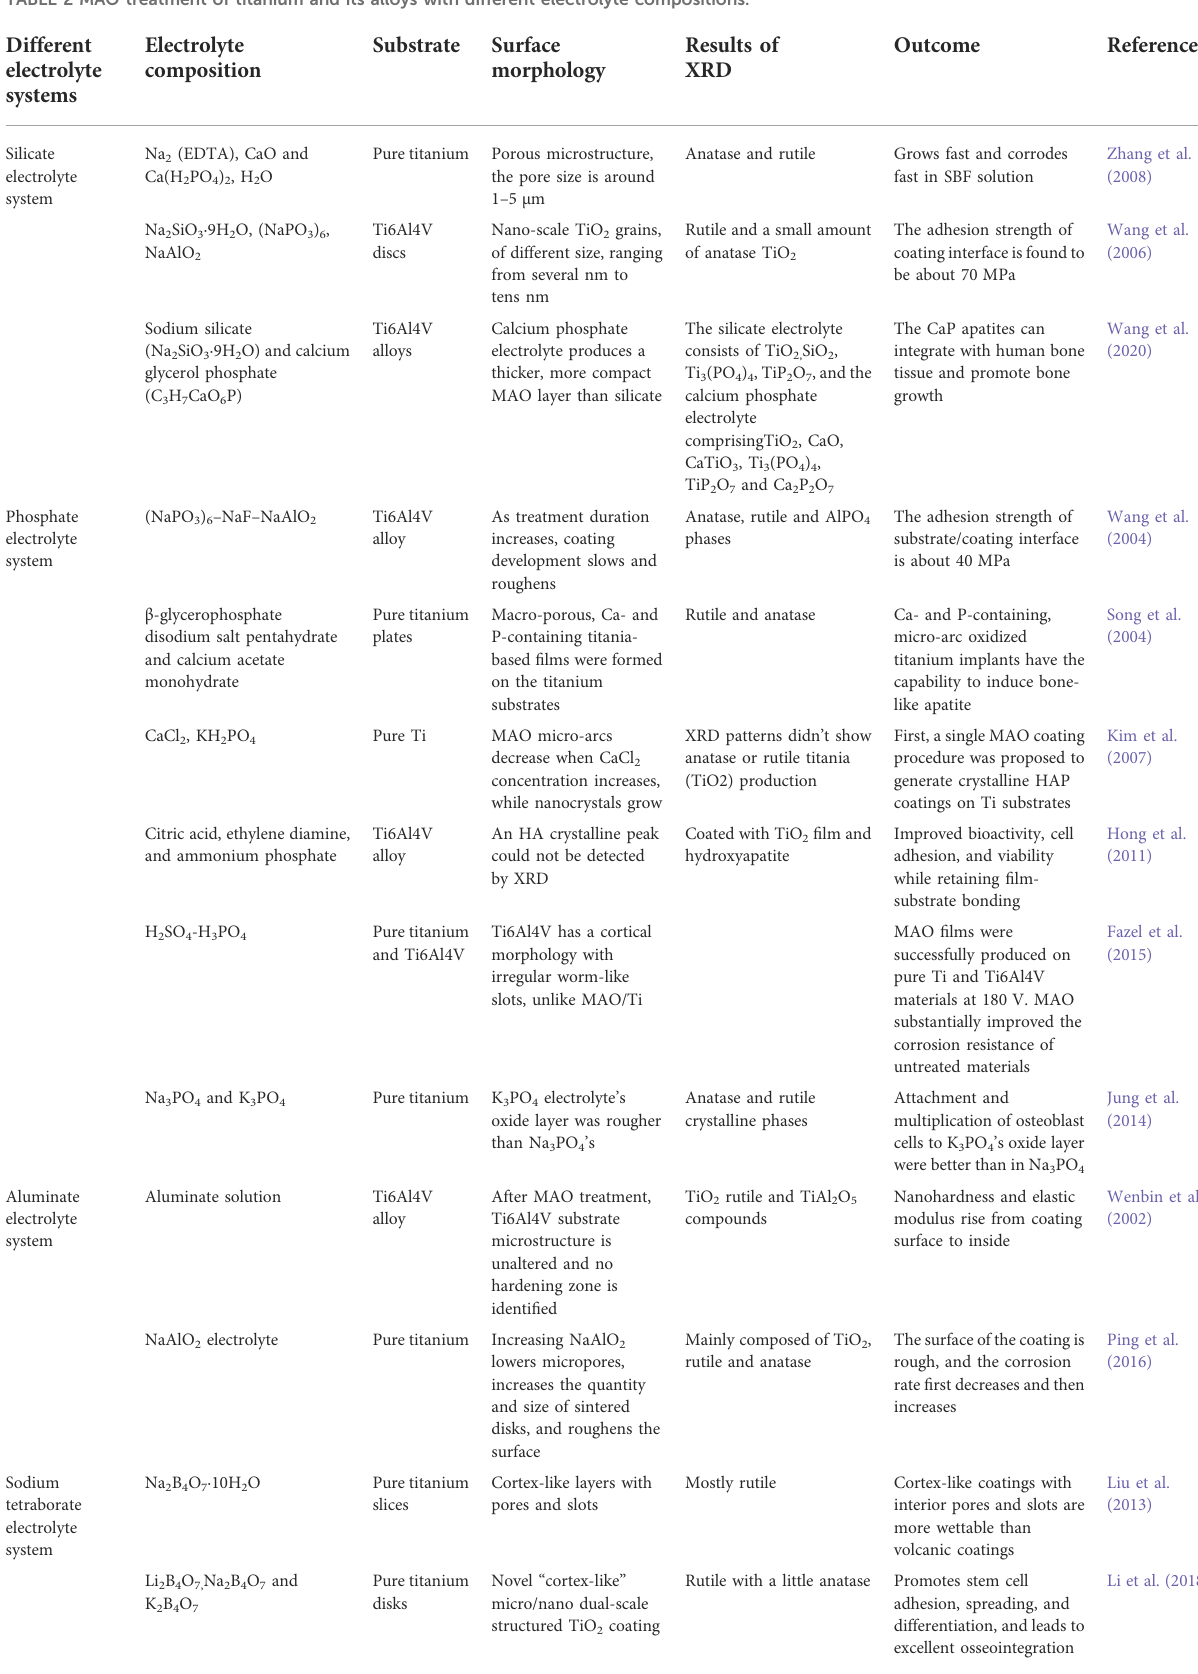
TABLE 2 MAO treatment of titanium and its alloys with different electrolyte